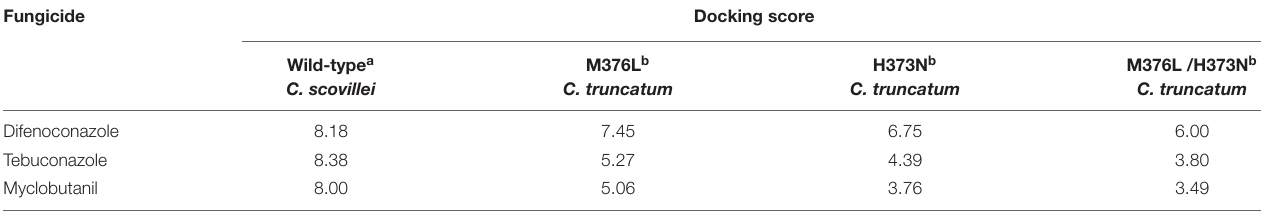
TABLE 5 | Total scores of three DMI fungicides docked into the CYP51 binding site of C. scovillei and C. truncatum models (M376L, H373N, M376L